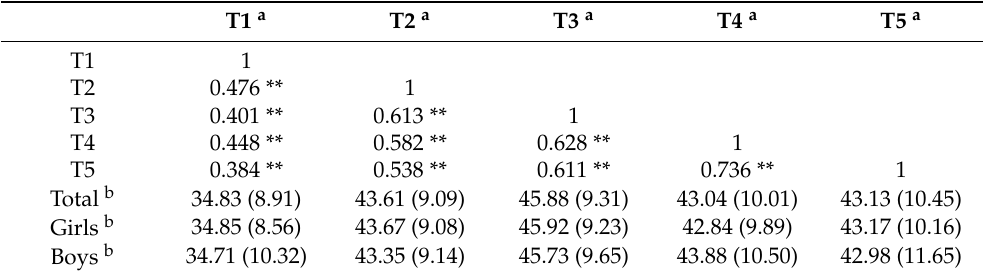
Table 2. Correlations of depressive symptoms among five measurement points and descriptive